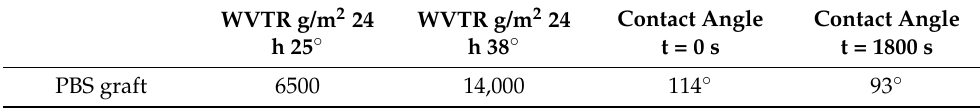
Table 2. Parameters obtained from WVTR and contact angle Table 2. parameters obtained from WVTR and contact angle analysis.